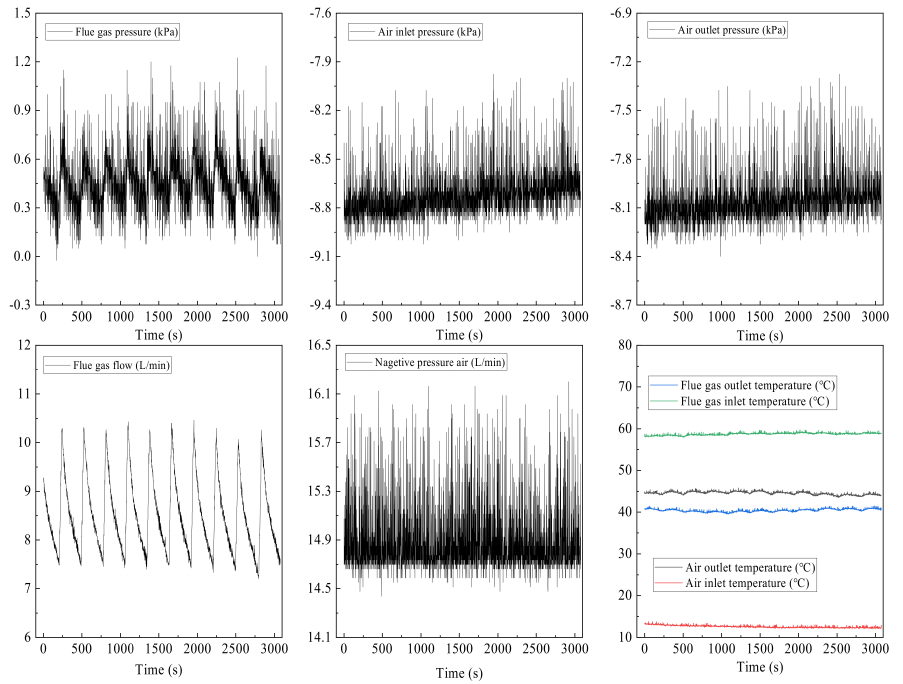
Figure 9. Running state parameters. Experiment conditions: flue gas flow 8.5 L/min, flue gas inlet temperature 58.6 ◦ C, negative pressure airflow 15 L/min, negative pressure air inlet temperature 12.8 ◦ C, membrane pore size 10